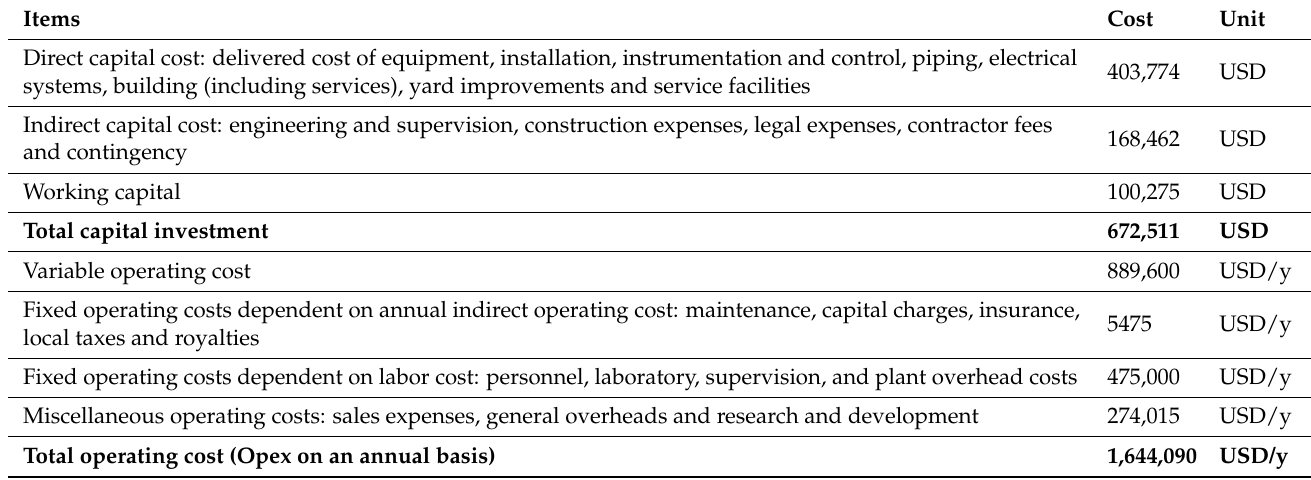
Table 4. Capital and operating costs of a 0.5 tph secondary plastic waste recycling plant.